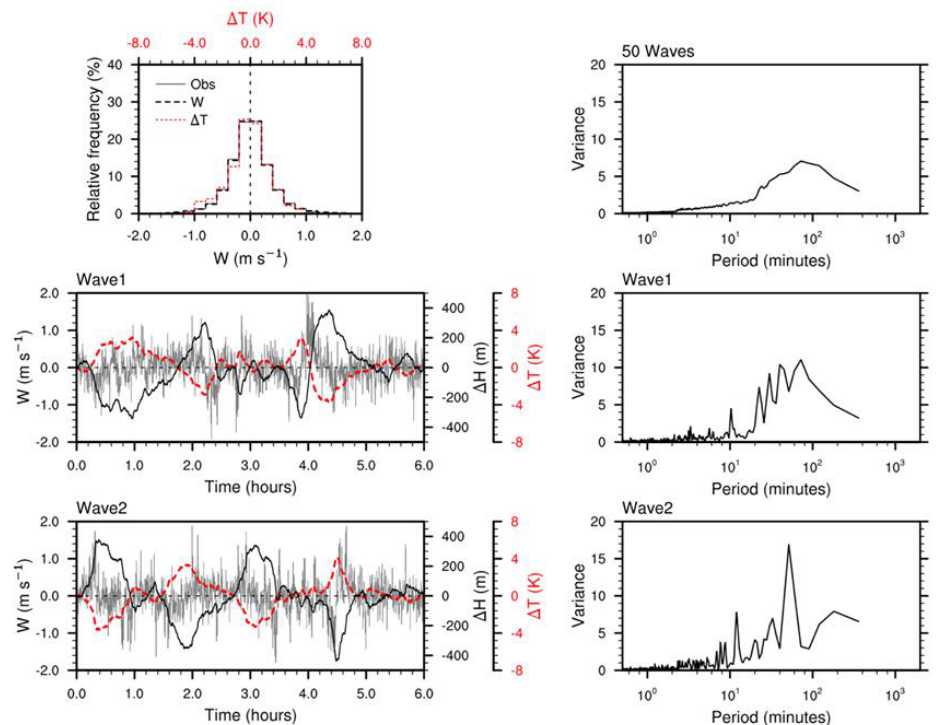
Figure 1. The statistical characteristics of the 50 prescribed W time series used to drive the parcel model (first row). They are the occurrence frequencies of W and ∆ T ( left ) and the spectrum analysis of the W time series ( right ). The second and third rows present two cases (Wave1 and Wave2, respectively). The left columns show the time series of W (gray solid line), the ∆ H (black solid line), and ∆ T (red dotted line). The right columns show the spectrum analyses of the corresponding W time series. The ΔT and ΔH were calculated using the parcel model, with the initial conditions of T= 225 K and P= 250 hPa.